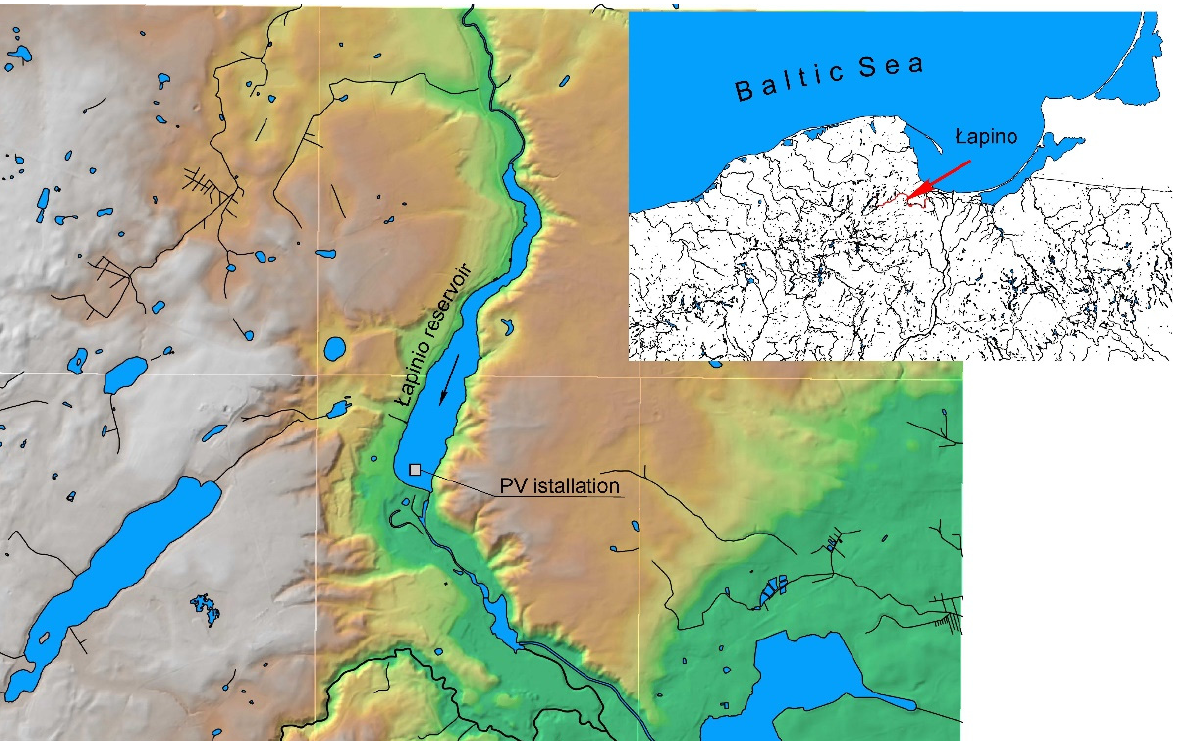
Figure 1. Location of the PV installation on the Ł apino Reservoir.